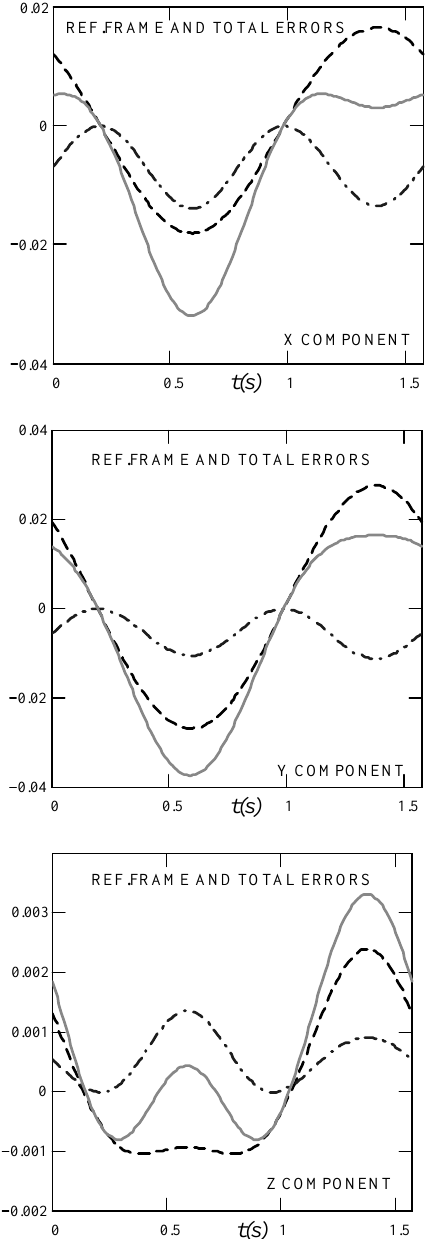
Fig. 3. Results of test case simulation: dimensionless errors. Dashed line: combination of position and orientation errors; dot-dashed line: [ err p ( IB ) ]; solid line: total error [ err p ( tot ) ] combination of the previous ones. The six accelerometer channels are supposed to acquire a Ox , a Oy , a Oz , a Py , a Pz , a Qz in the BRF. The FFT of the data is rather simple since only one frequency is present; indeed second order effects can be observed. From amplitudes and phases the linear acceleration and velocity can be obtained according to Eqs (7–8) and, applying Eqs (11–16), also angular velocity and acceleration components can be calculated. In Figs 4 and 5 the dimensionless errors, that is the difference between theoretical and calculated values scaled by the amplitude, are reported, for angular velocity and acceleration